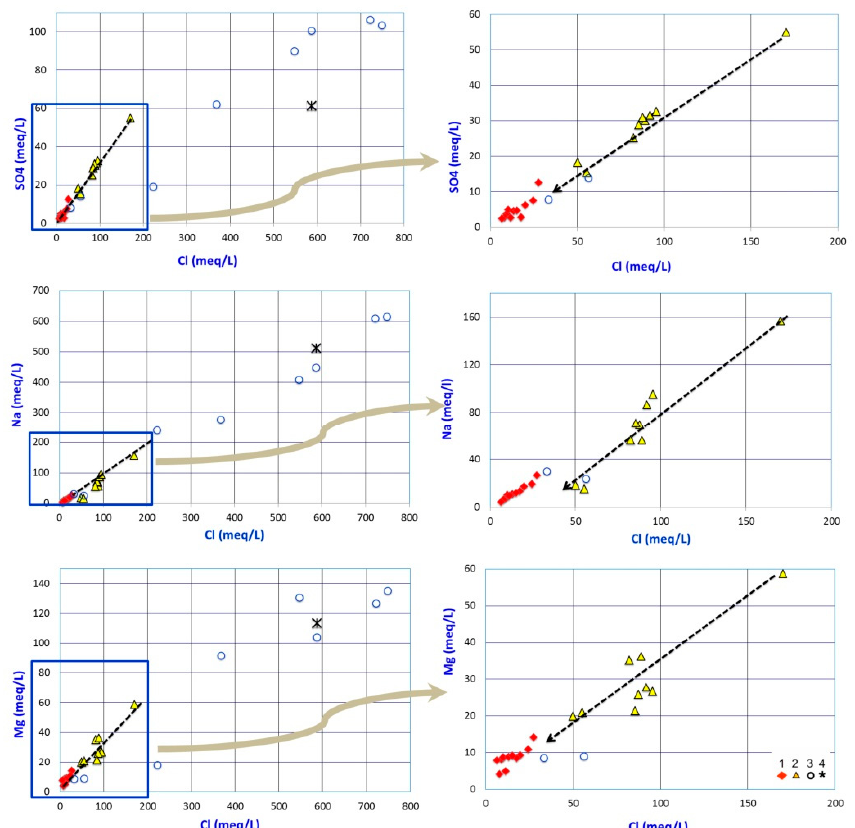
Figure 8. Ionic ratios in surface water of coastal and inland wetlands and groundwater of shallow aquifer. 1: shallow aquifer. 2: Balsa del Sapo. 3: Punta Entinas. 4: Sea water. Point location in Figure 1a. The arrow in the graphs to the right shows the time evolution of surface water in the Balsa del Sapo wetland. Balsa del Sapo data from [25].